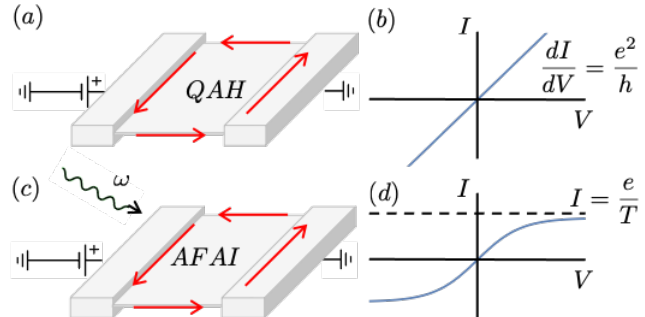
Figure 1: (a) The stationary QAH phase demonstrates a chiral edge state. Therefore, the slope of the I − V curve, i. e. the conductivity is quantized to ∼ e 2 / h for small voltage, with only minor corrections at higher voltage. (b) In the AFAI the current behaves in the same way at small bias, but it saturates to e / T at higher voltage, leading to a quantized current [ 50,58 ]